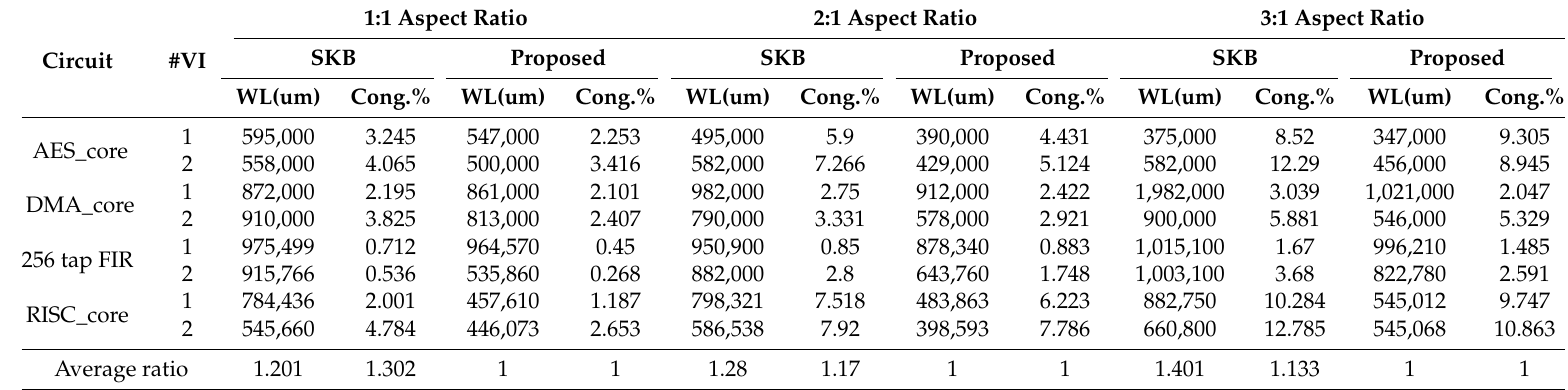
Table 4. Comparisons with conventional floorplanner for fixed outline floorplanning with 15% deadspace on various aspect ratios of chips.